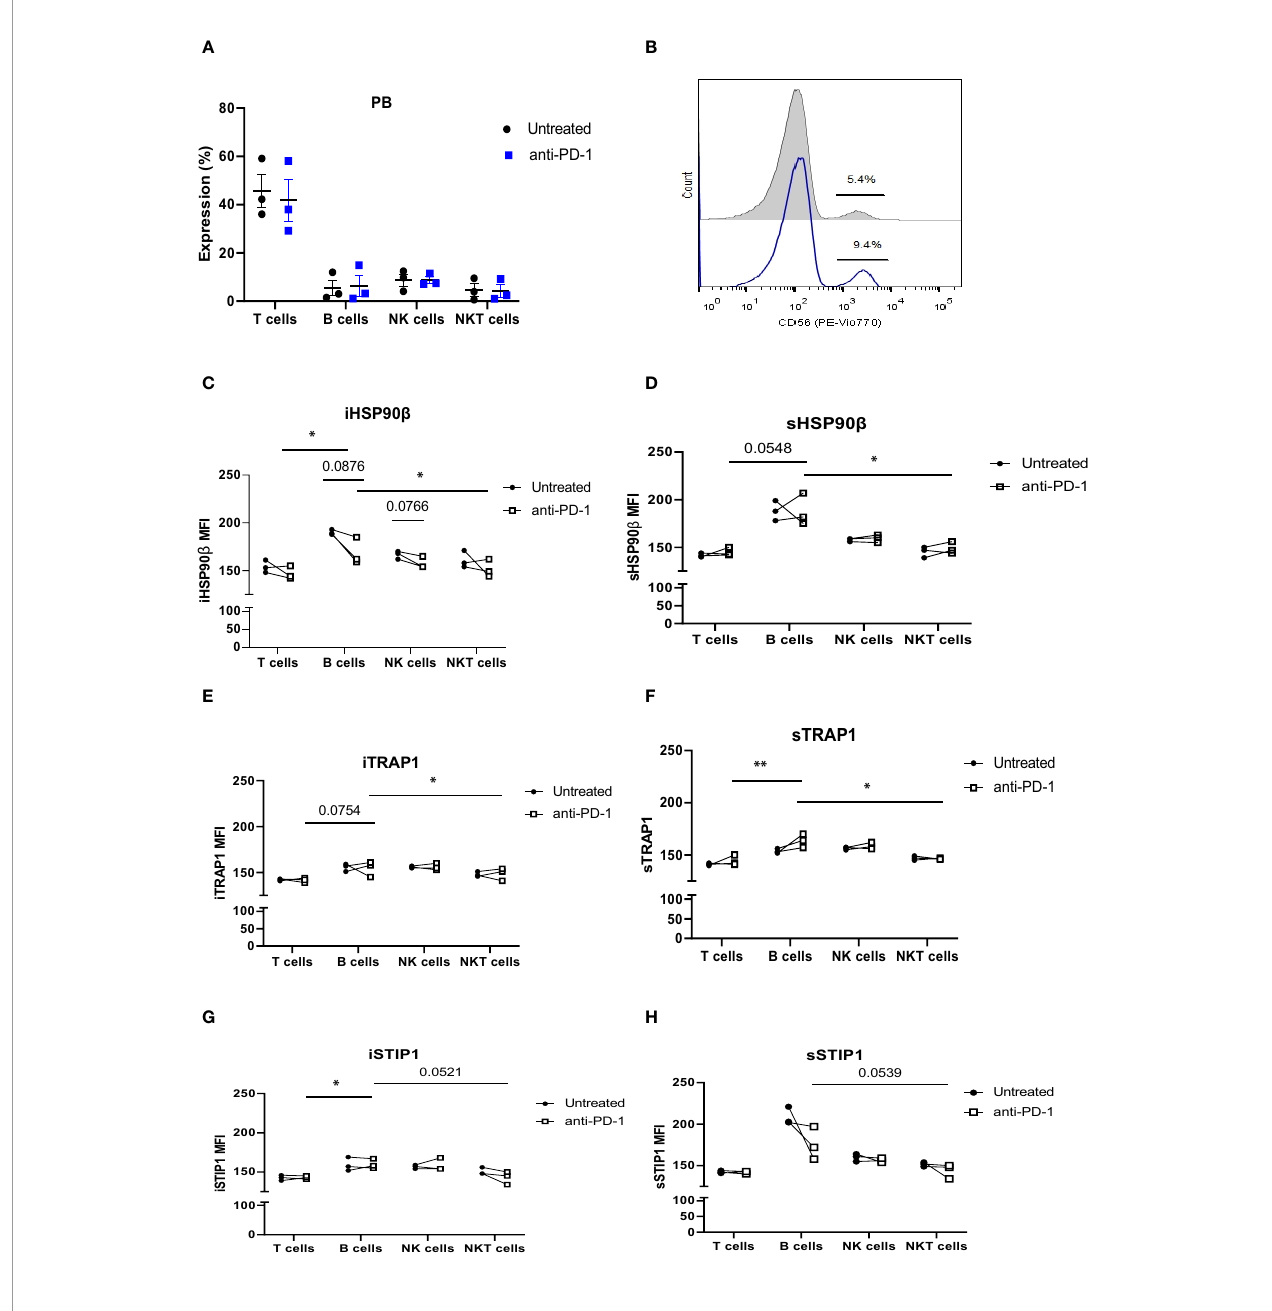
FIGURE 5 | The effect of anti-PD-1 treatment on HSP90 expression in peripheral blood lymphocytes in r/r cHL patients. (A) Frequencies of T, B, NK and NKT cells following 24hr treatment with Nivolumab in r/r cHL patients (n=3). (B) Representative histogram showing increase in NK cell frequency after 24hr treatment with Nivolumab. iHSP90 b expression (C) and sHSP90 b (D) , iTRAP1 (E) and sTRAP1 (F) , iSTIP1 (G) and sSTIP1 (H) in peripheral blood lymphocytes of r/r cHL patients at 24 hrs treatment with Nivolumab (n=3). ns, not signi fi cant, *p<0.05, **p<